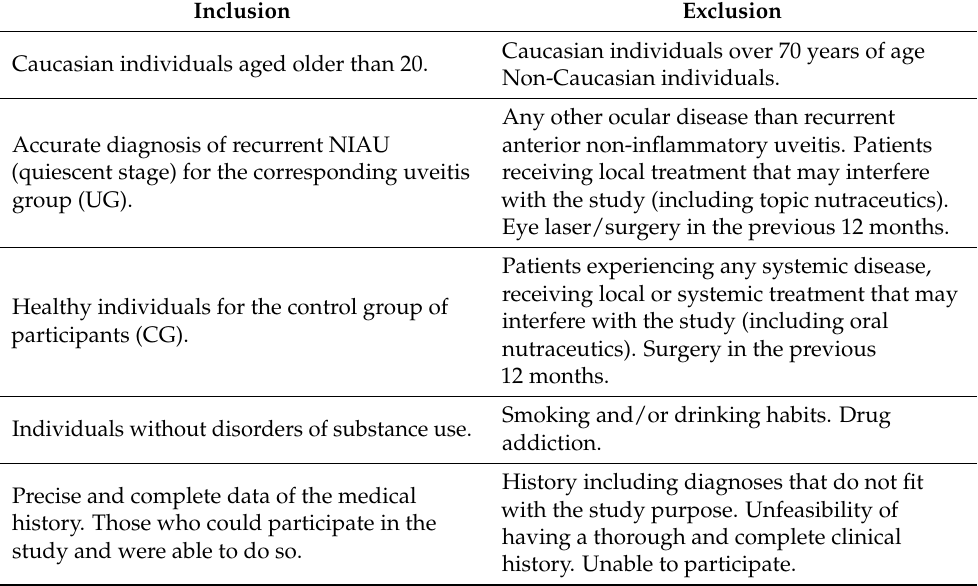
Table 1. Inclusion and exclusion criteria for the study